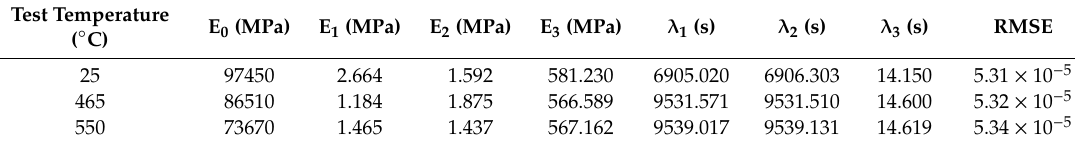
Table 2. The numerical fitting results of the creep